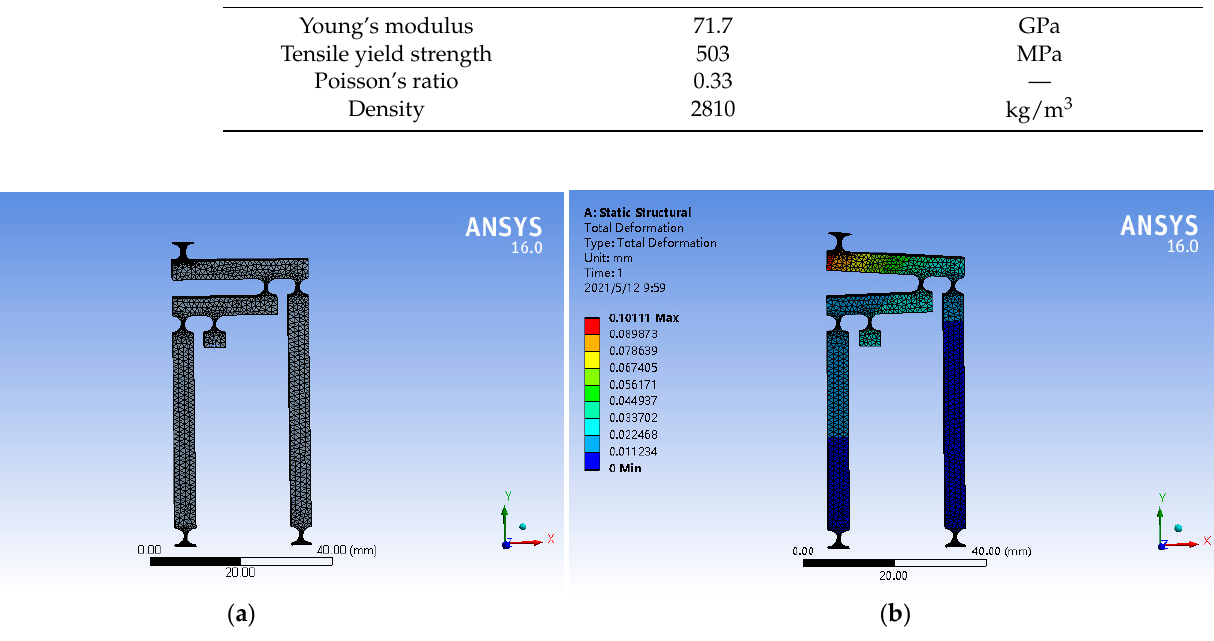
Figure 5. Meshing results of the mechanism ( a ); simulation of amplifier mechanism ( b ). Table 3. Physical and mechanical parameters of the material Al7075-T651.